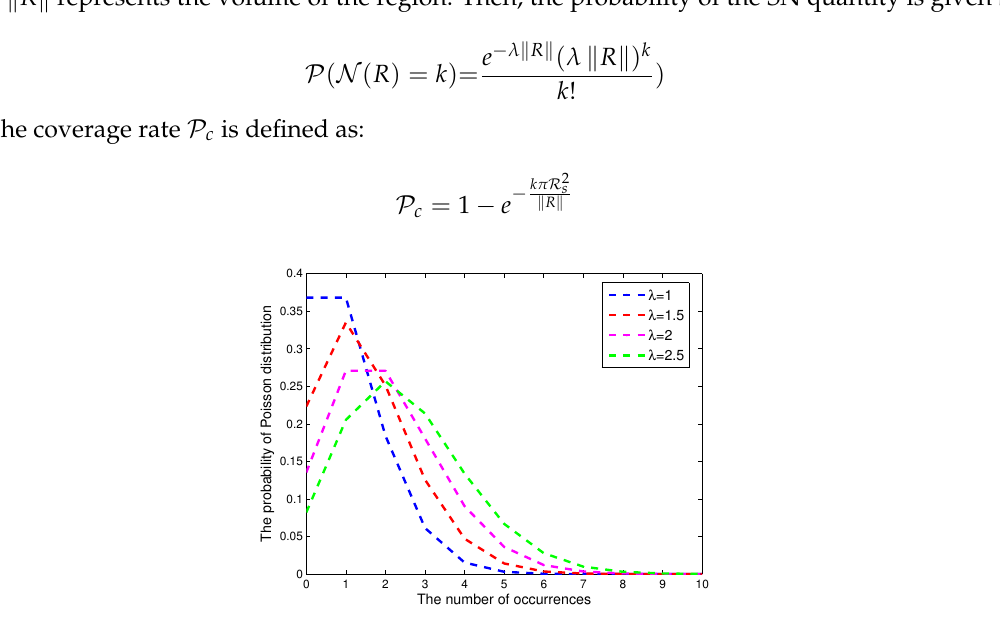
Figure 2. The probability of the Poisson